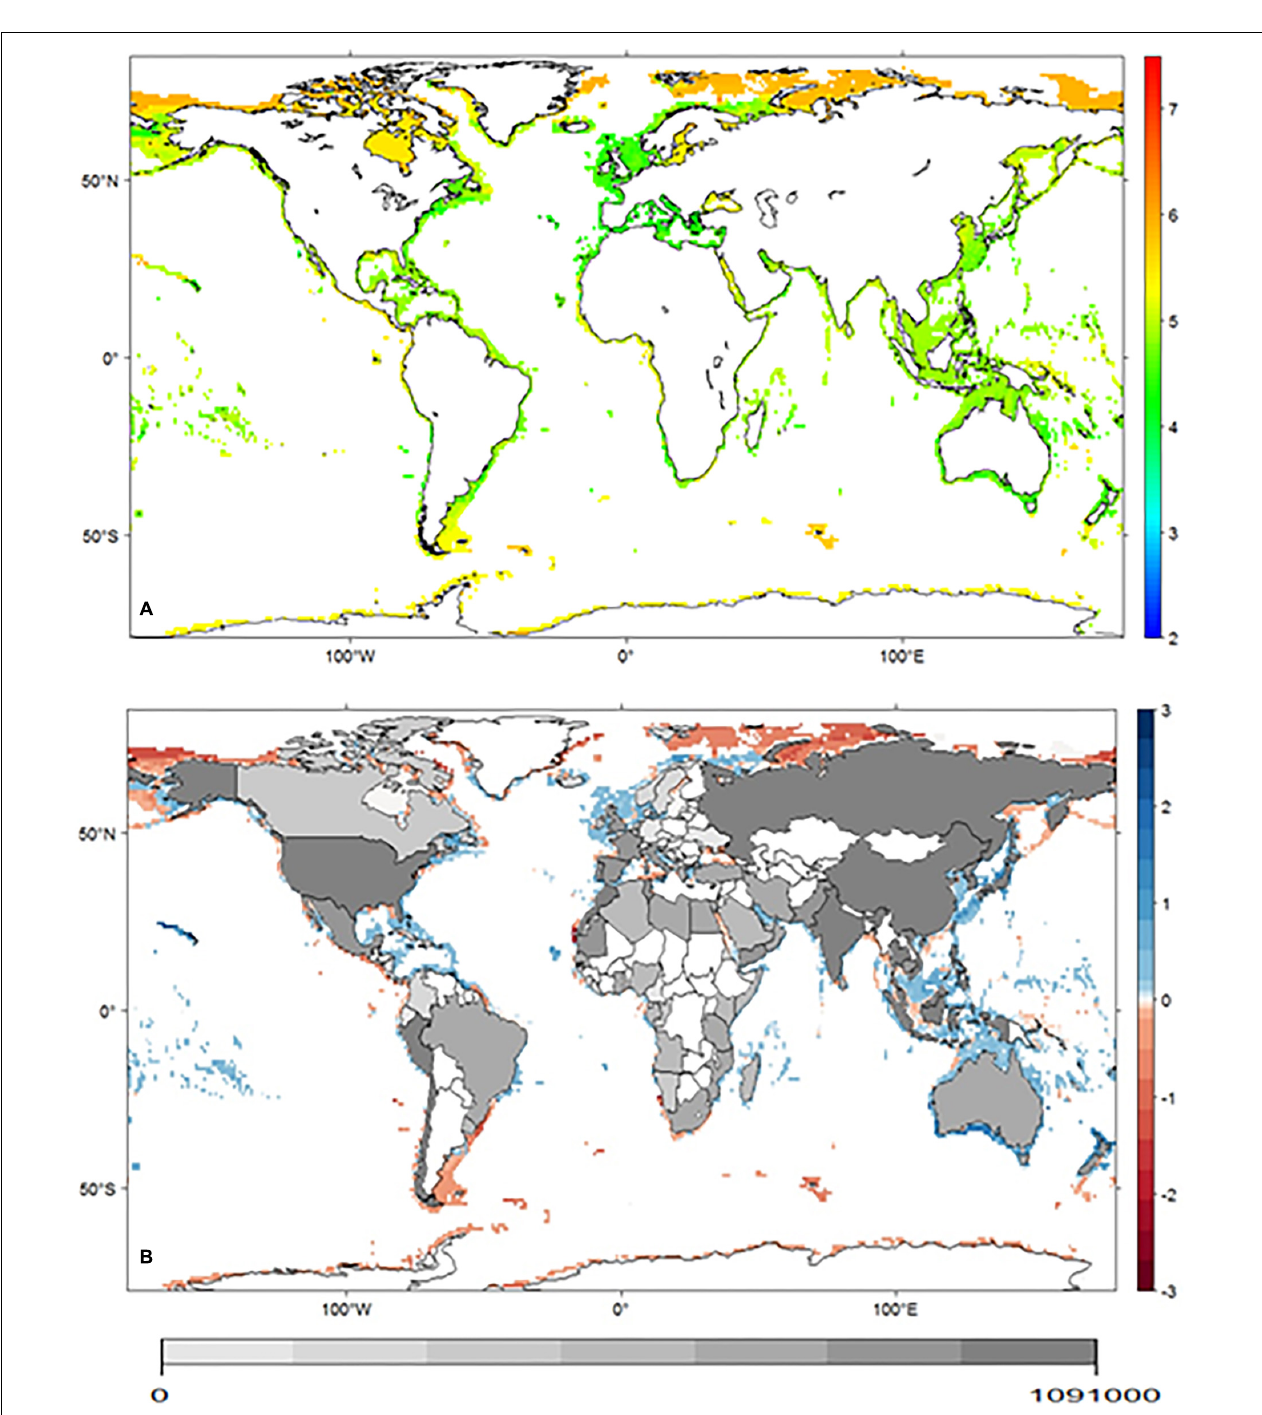
FIGURE 3 | (A) Distribution of geometric mean body size (log) projected for the cephalopod group, in the baseline period. Lateral panel represents the mean body size predicted for the baseline (blue line) and for the future (red line) period. (B) Net differences in geometric mean body size predicted between the two periods. Inland shades of gray represent cephalopod global capture production per country (ton) [2016 data – FAO (2016)]. environmental space for cephalopod species to do so. However, Given the increasing number of cross-factorial studies our models do not consider the potential for rapid acclimation showing the deleterious interacting effects of ocean warming and adaptation (Munday, 2014), which could give cephalopods and acidification on the development and physiology of time and evolutionary opportunities to adapt to future changes. marine invertebrates (Portner, 2008; Findlay et al.,